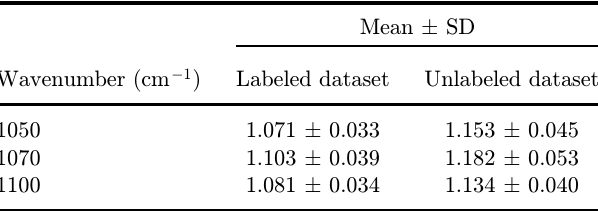
Table 3. Absorbance normalized by a wavenumber of 1000 cm (cid:2) 1 for each dataset.